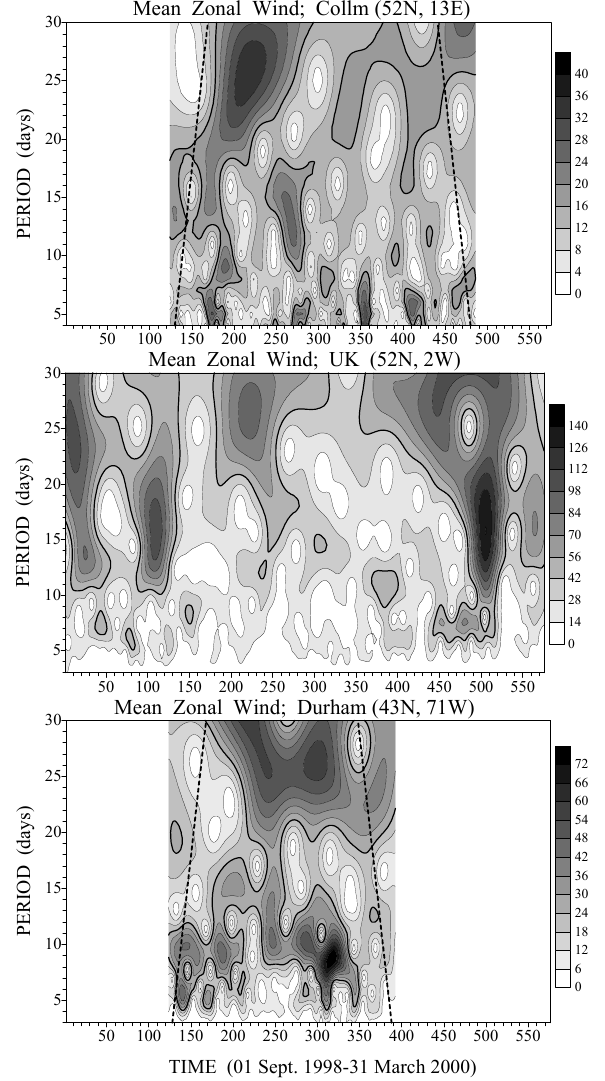
Fig. 2. Wavelet spectra of the zonal winds measured in Collm, Ger- many (upper plot), in UK (middle) and in Durham, USA (bottom) in the period range 3–30days.